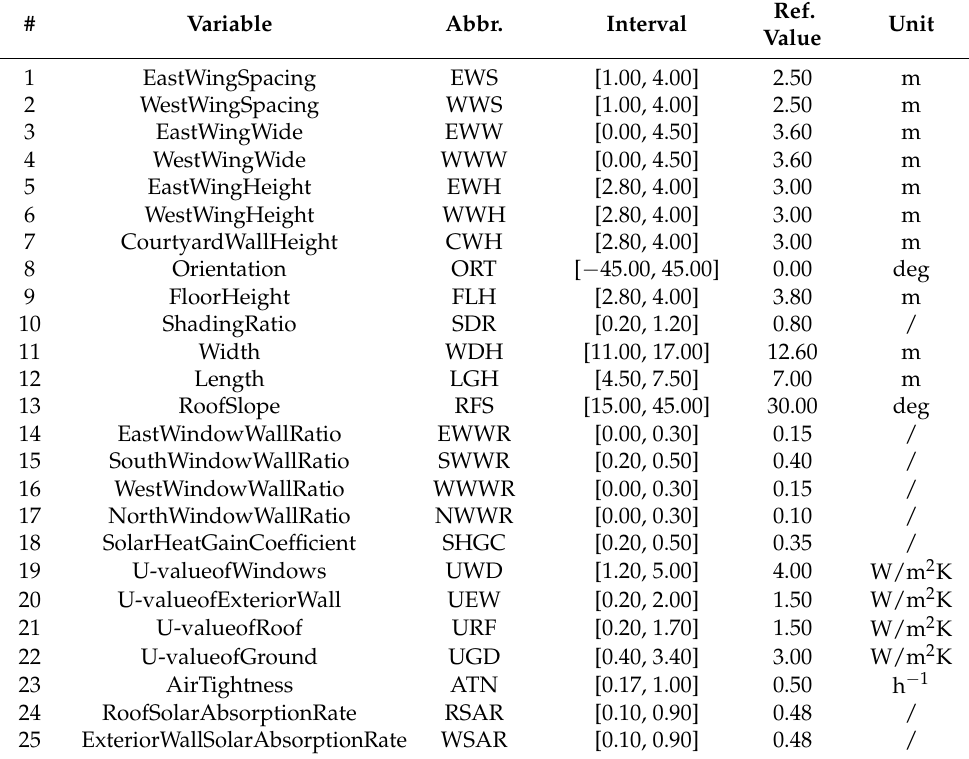
Table 2. Extracted design variables and their details.